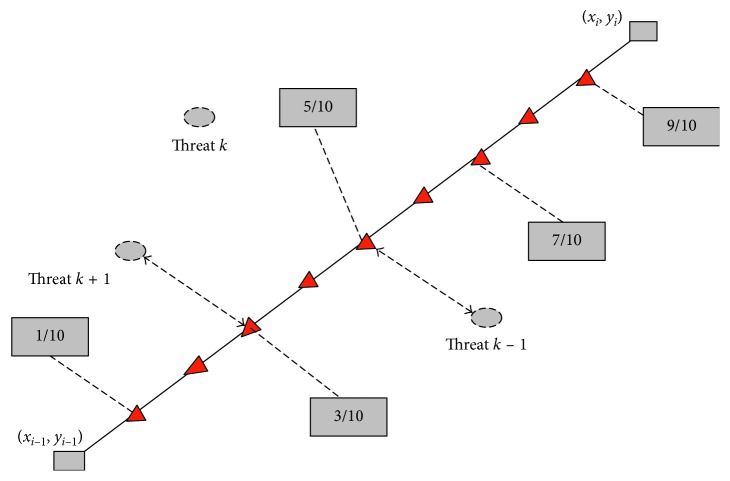
Threat cost model.